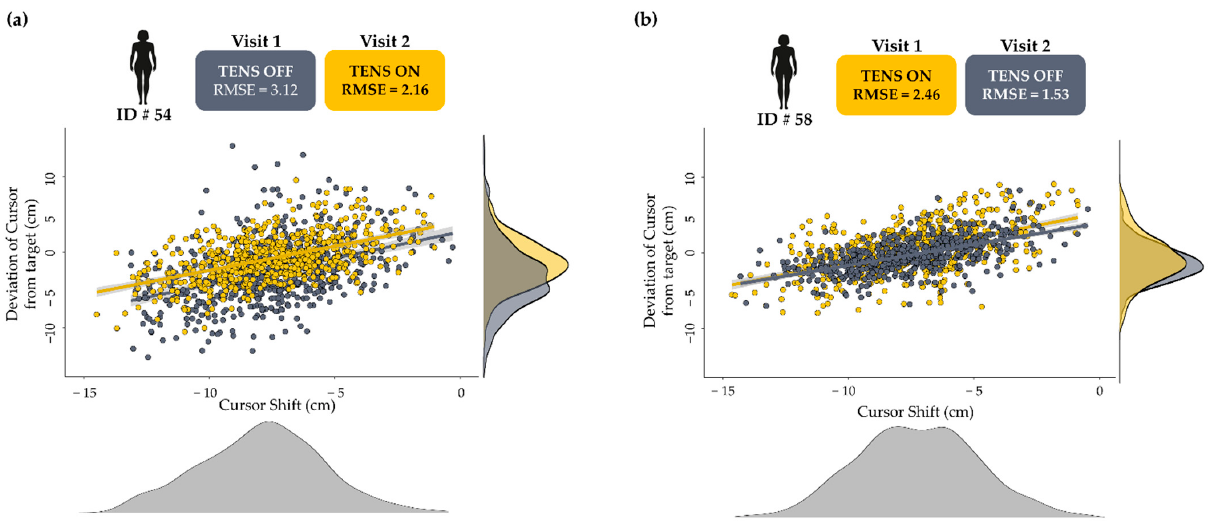
Figure 4. The scatter and density plots of the two participants’ responses who received TENS on their second and first visit, respectively. We found that both groups reduced the uncertainty in their responses from visit 1 to visit 2, with the group who received TENS on their first visit (TN) reporting the least degree of uncertainty. ( a ) Data from a participant that received TENS on the second visit. ( b ) Data from a participant that received TENS on the first visit. Both participants reduced the un- certainty in their estimates from visit 1 to visit 2 with the participant in ( b ) showing the lowest un- certainty.